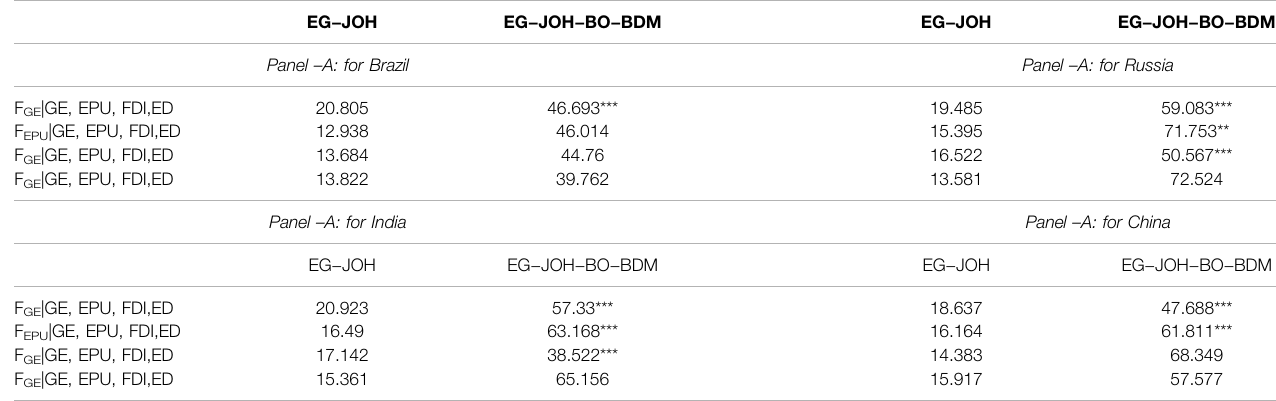
TABLE 5 | Results of Bayer and Hanck combined cointegration